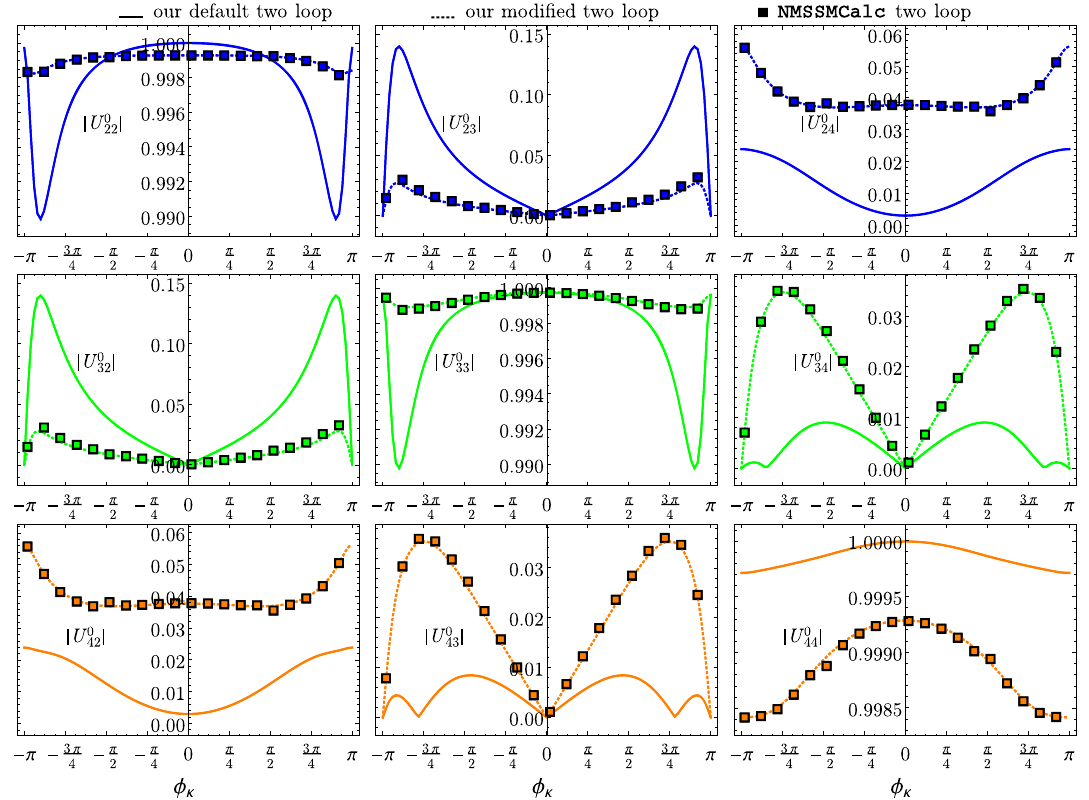
| in our calculation ( solid curves ), in NMSSMCALC ( squares ), and in our modified calculation closer to the options Fig. 9 The matrix elements | U 0 ij of NMSSMCALC ( dotted ) for the scenario of Fig.